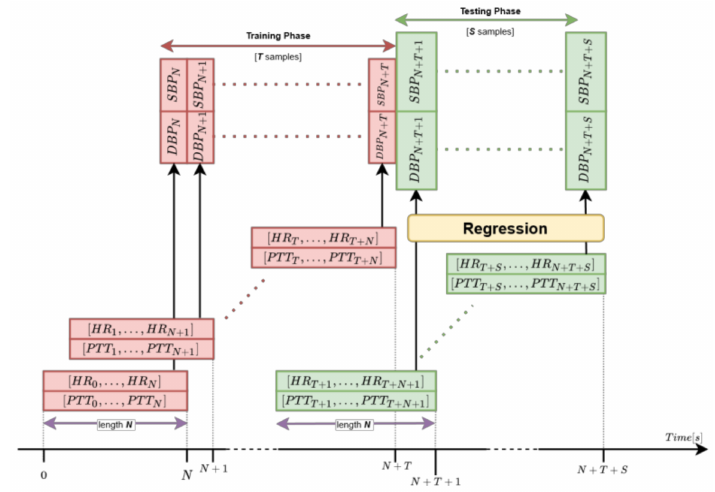
Figure 12. Regression process with signals from the MIMIC III database.